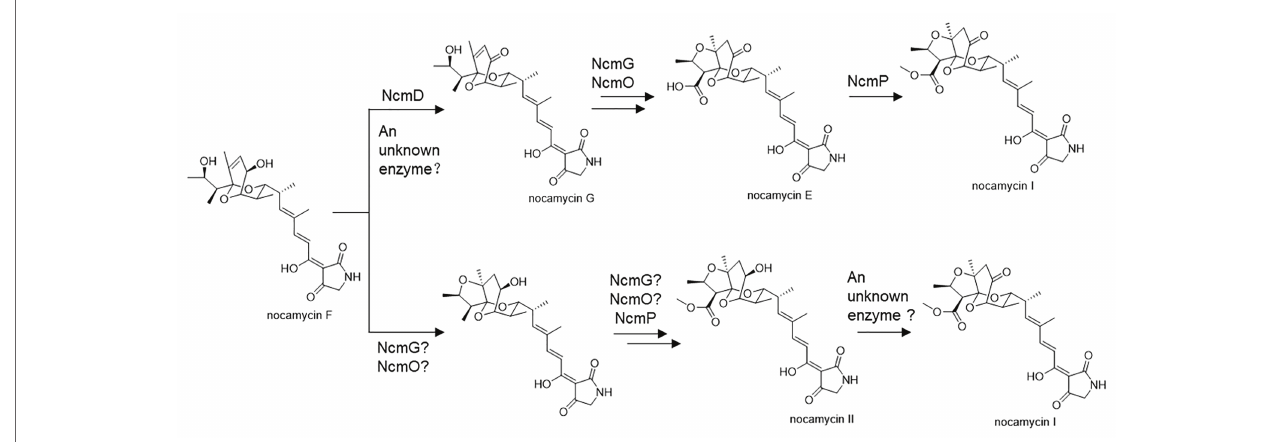
FIGURE 6 | Putative post-tailoring pathway for